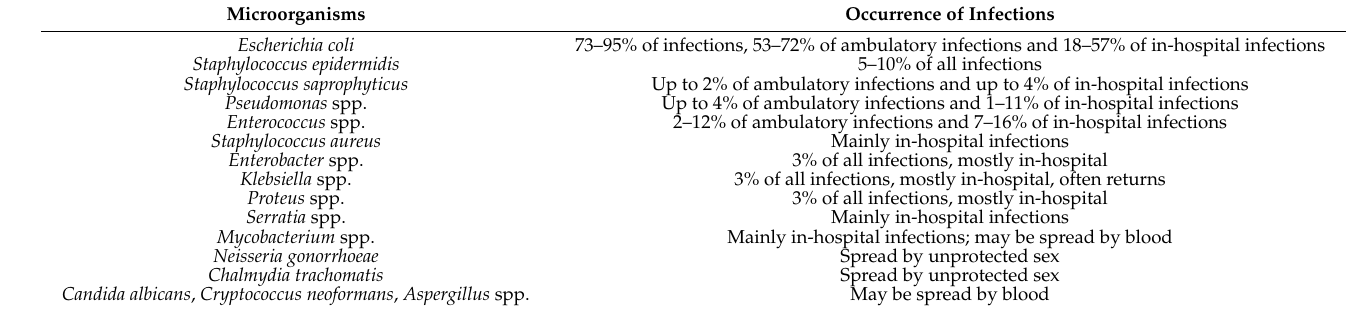
Table 1. Microorganisms associated with inflammations of the lower urinary tract [3,6–8]. Microorganisms